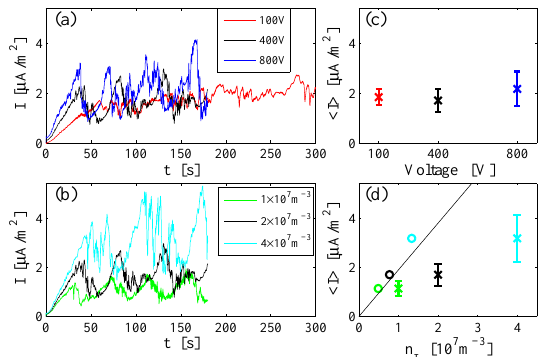
Figure 8. Currents in simulation runs with (a) different voltages and (b) different ionospheric densities; the current as a function of (c) voltage and (d) ionospheric density. The mean and the standard deviation, shown by the error bars, in panels (c) and (d) have been computed for t> 60s. The densities that were used for the circles in panel (d) were taken 3.5km from the ionospheric boundary, and the black line shows the current corresponding to the electron flux of a Maxwellian with k B T e =